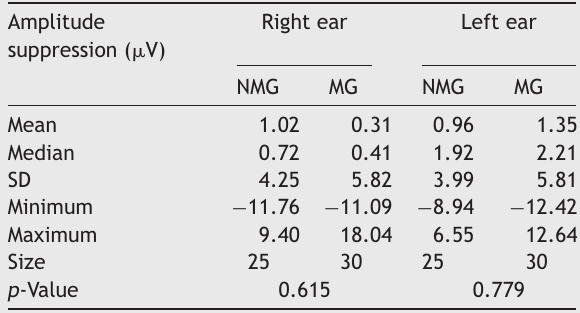
Comparison of the P300 amplitude suppression ( (cid:2) V) between the NMG and the MG for the right and left